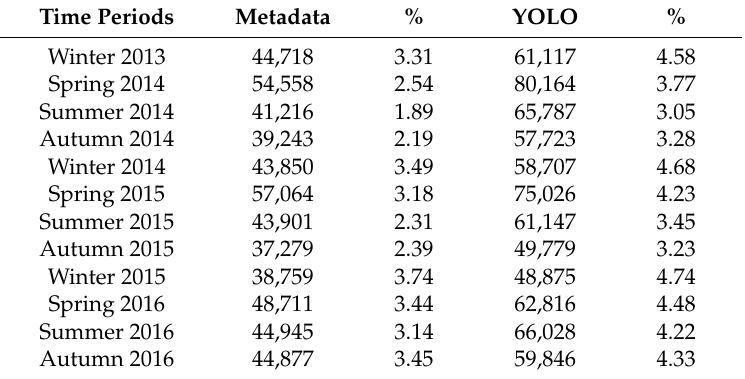
Table 2. Bird photograph